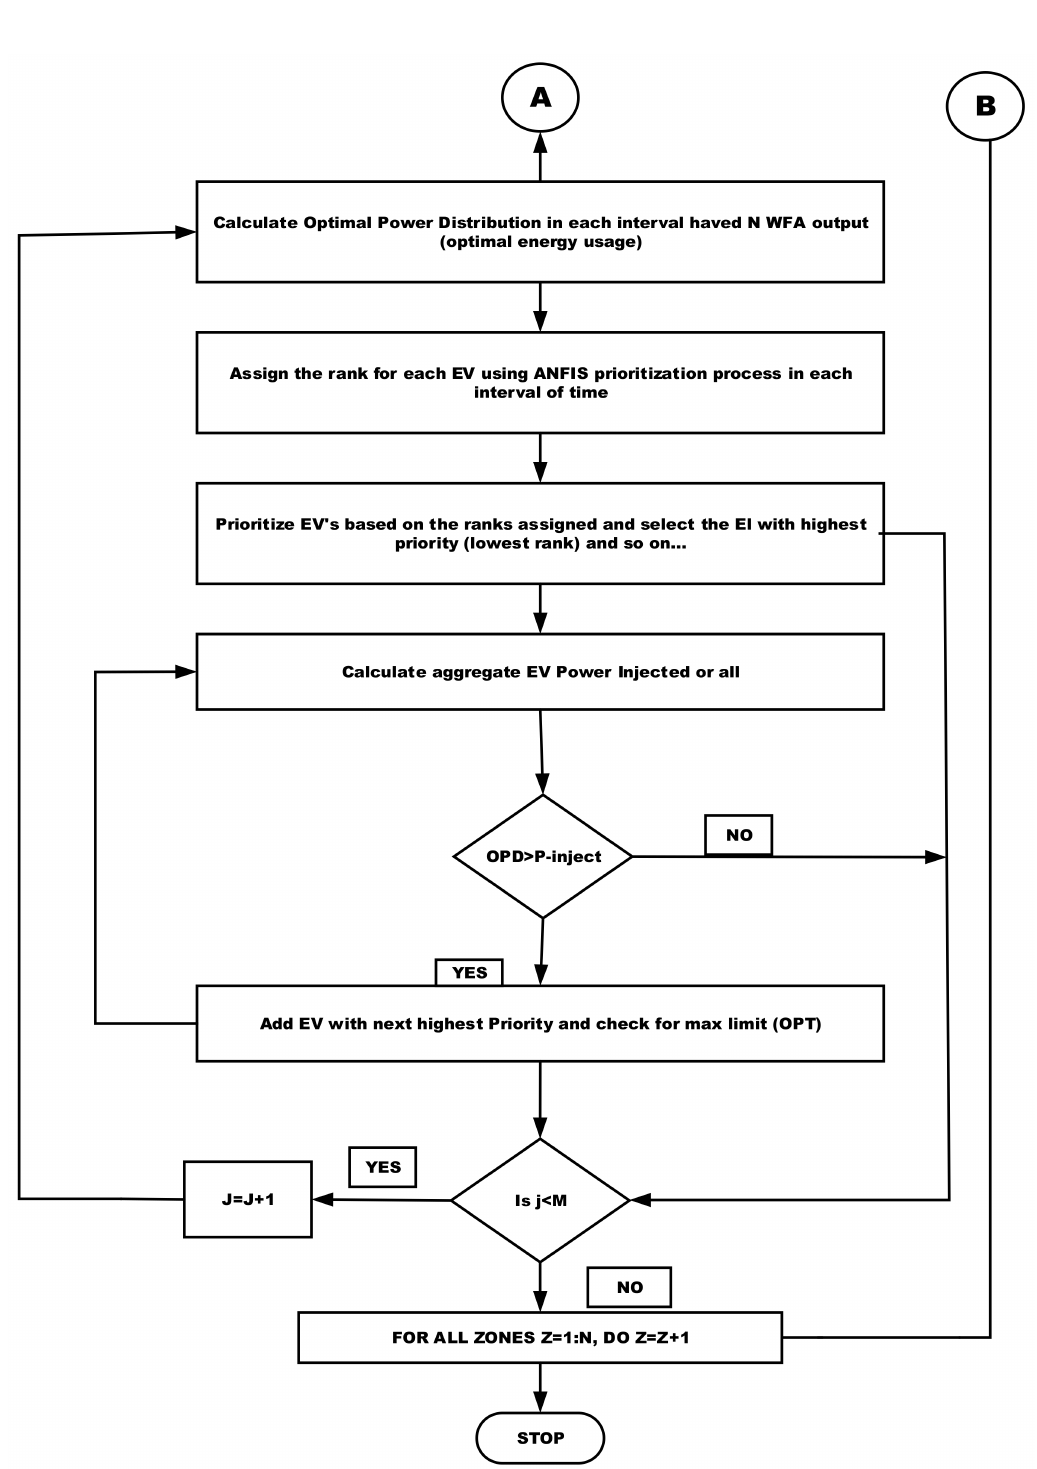
Figure 1. Proposed EMS for MG in flowchart